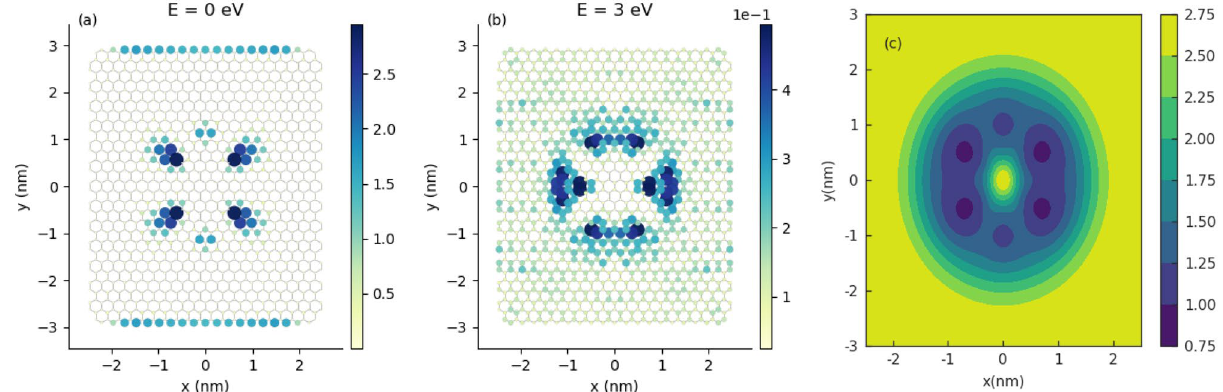
0 = 2nm, σ 1nm, σ 0.8nm G = x = =